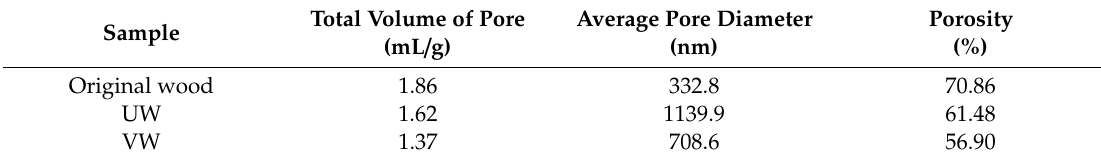
Table 3. Pore conditions of original wood, UW, and